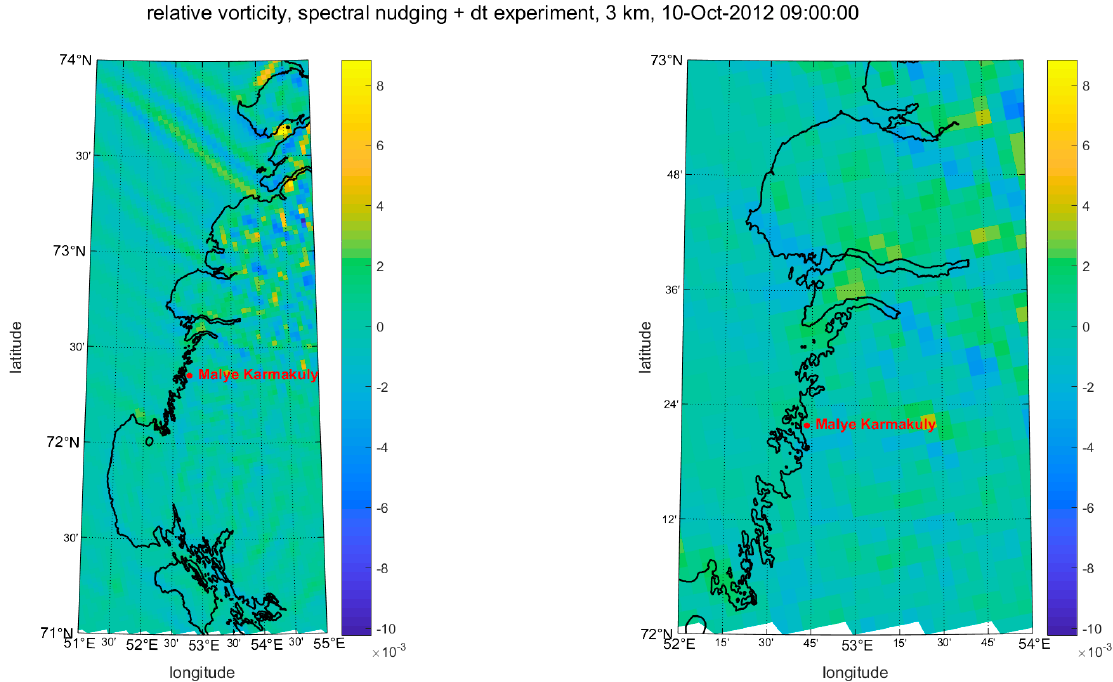
Figure 11. The same as in Figure 6, for the Malye Karmakuly station region on 10 October 2012 at 09:00 GMT.